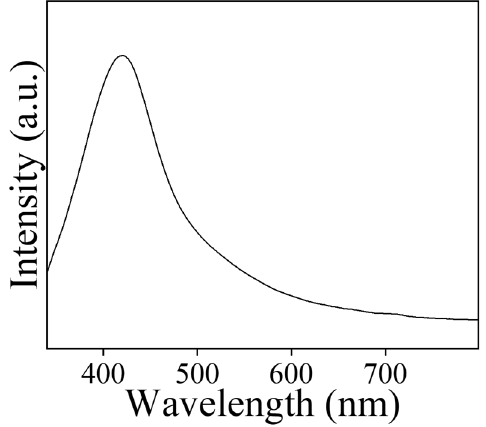
Figure 3. Fluorescence measurement of neodymium selenide nanoparticles.